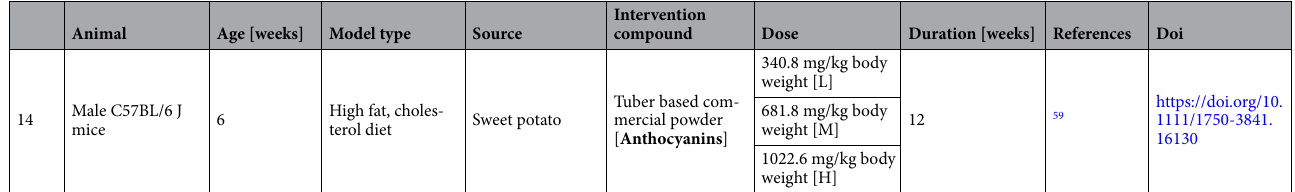
Table 2. Characteristics of the studies used to investigate the effect of anthocyanins on the short chain fatty acids [SCFA’s]. # For understanding the effect of dose, different interventions given to animals were uniformalised to mg/kg body weight. For dose conversion in mg/kg of body weight, the average weight and diet considered for mice were 22 g and 2.5 g, and for rats were 200 g and 11 g, respectively.